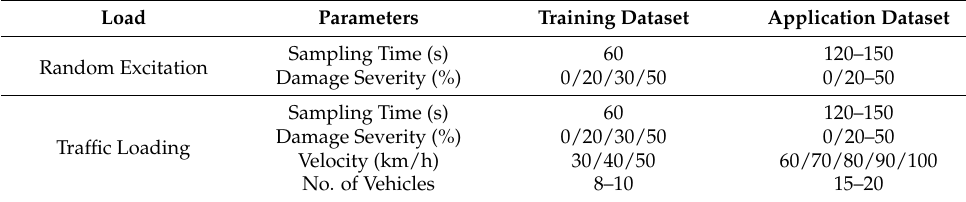
Table 7. Configurations of application datasets.